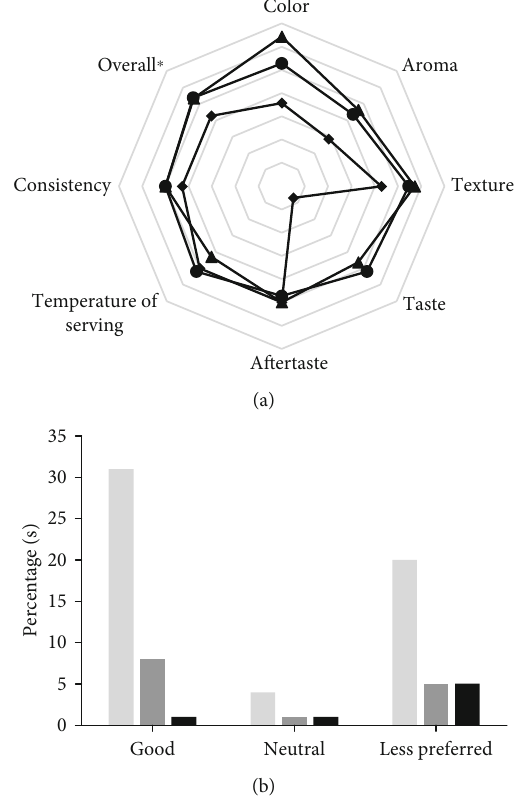
Figure 1: The level of preference based on preference (a) and acceptance (b) of the elderly towards cream soup: ( ● ) youngest- old, ( ▲ ) middle-old ( ⬥ ) oldest-old, (light gray square) youngest- old, (dark gray square) middle-old, and ( ■ )